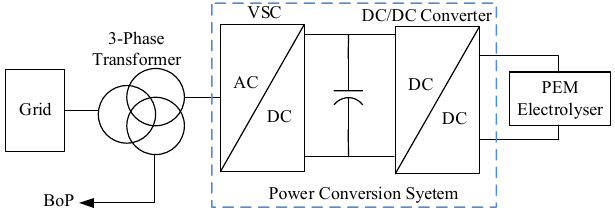
Figure 2. Connection of the inverter interfaced 300 MW PEM electrolyzer [14].